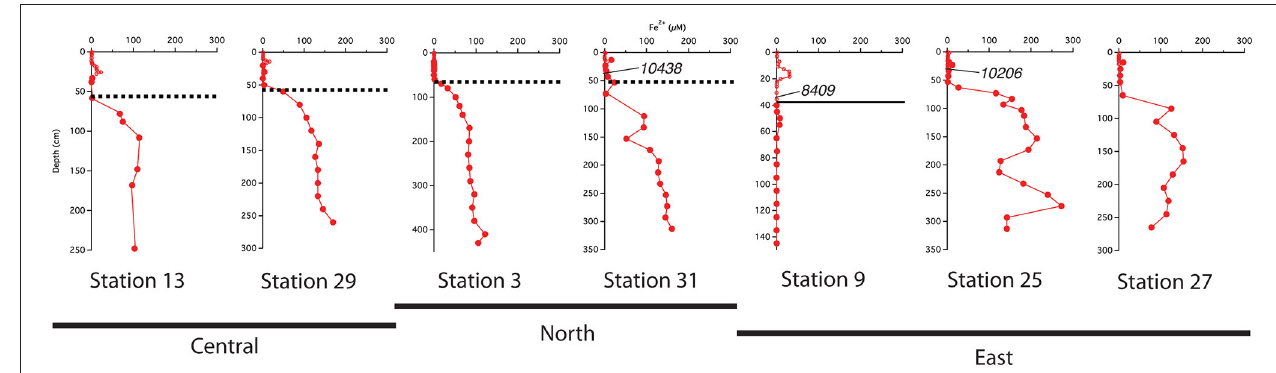
FIGURE 6 | Comparison of the location of the indurated iron crust with the pore water profiles. Dashed lines represent the iron crust identified by Mortazavi (2012). The solid line at station 9 represents the depth of the color change from tan to gray. Central refers to stations south of 10 ◦ N and west of 50 ◦ W; North refers to stations above 10 ◦ N; East refers to stations east of 50 ◦ W. Calendar ages measured from bulk 200 µ m sieved material are indicated where available.